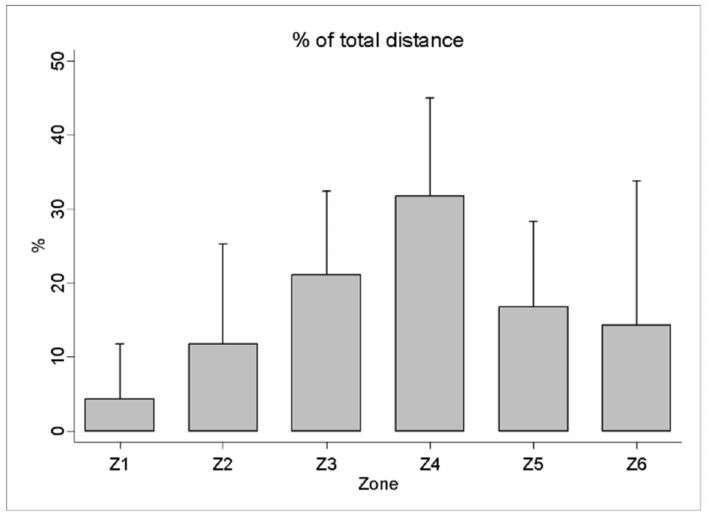
Figure 3. Distribution of heart rate expressed as the percentage of game time taken in the different ranges of HR MAX during a beach handball